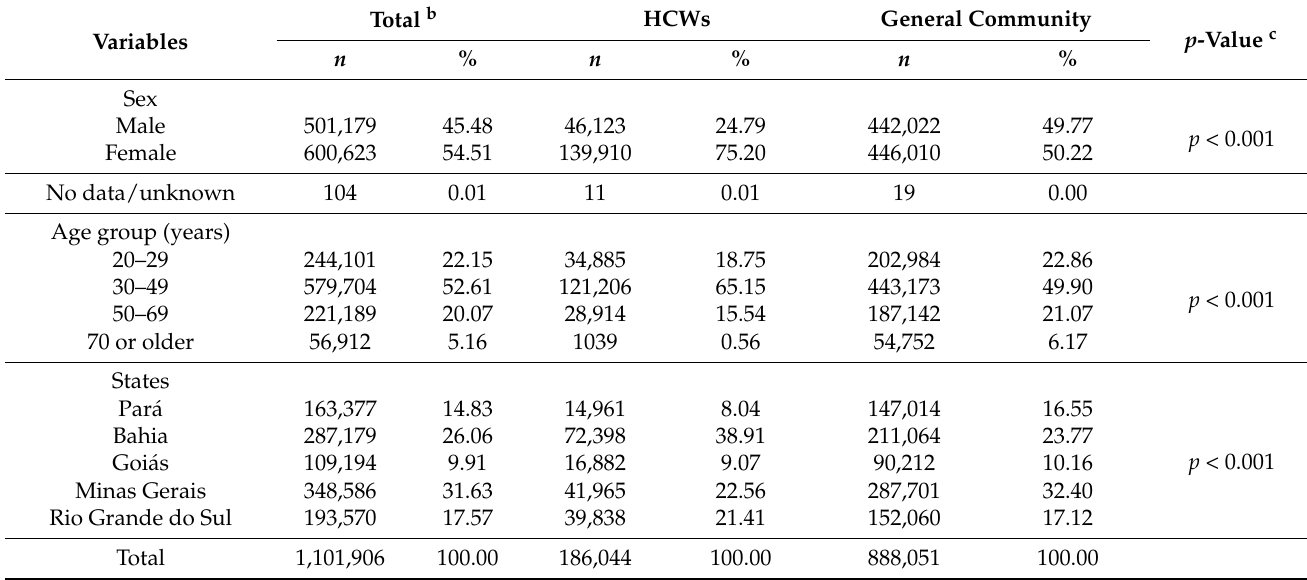
Figure 1. Incidence rates of clinical and epidemiological data of cases of flu-like syndrome in Brazil a , considering health care workers (HCWs) and general community. DATASUS, Population Census b and National Register of Health Establishments, 2020. a It is equivalent to the total number of cases in the largest states of each macro-region in the country, considering the number of municipalities. The data was updated until 27 June 2020. b The values of the 2010 census were adjusted considering the population projection for 2020 of the IBGE. ICU: intensive care unit. Table 1. Absolute and relative distribution of cases of flu-like syndrome in Brazil a , considering health care workers (HCWs) and general community. DATASUS, e-SUS Notifica,